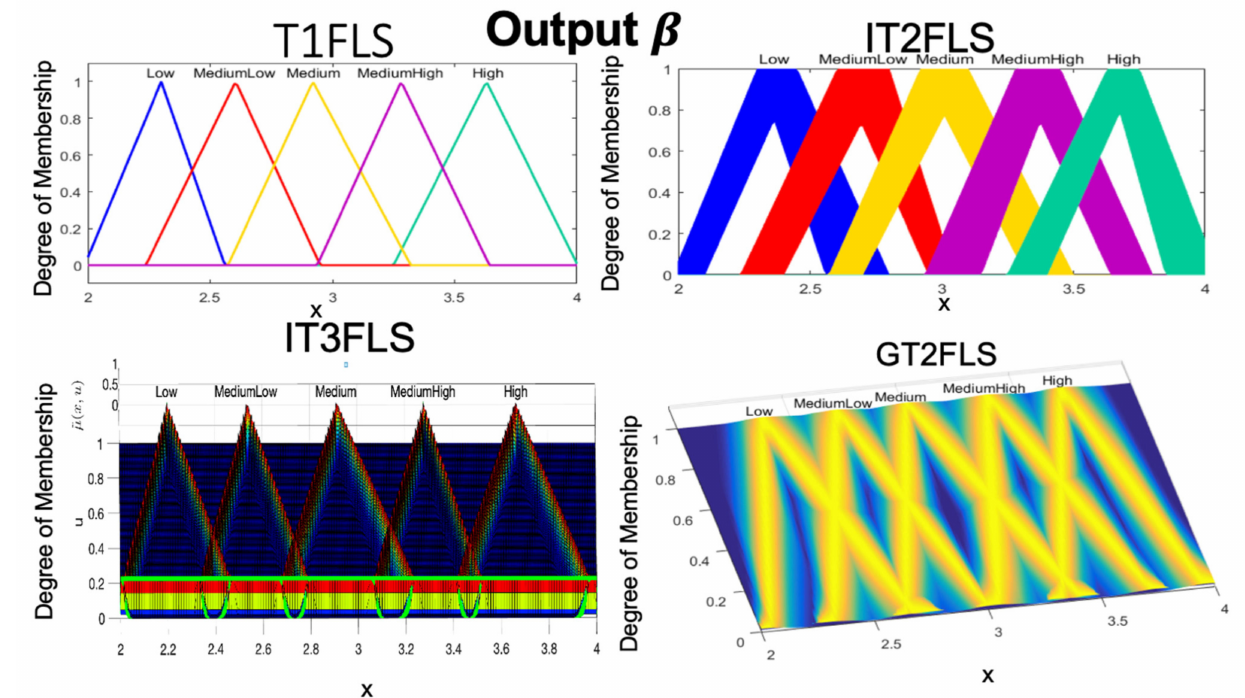
Figure 11. Visual representation of the Triangular MF (output 1- β ) for each Fuzzy Sets.